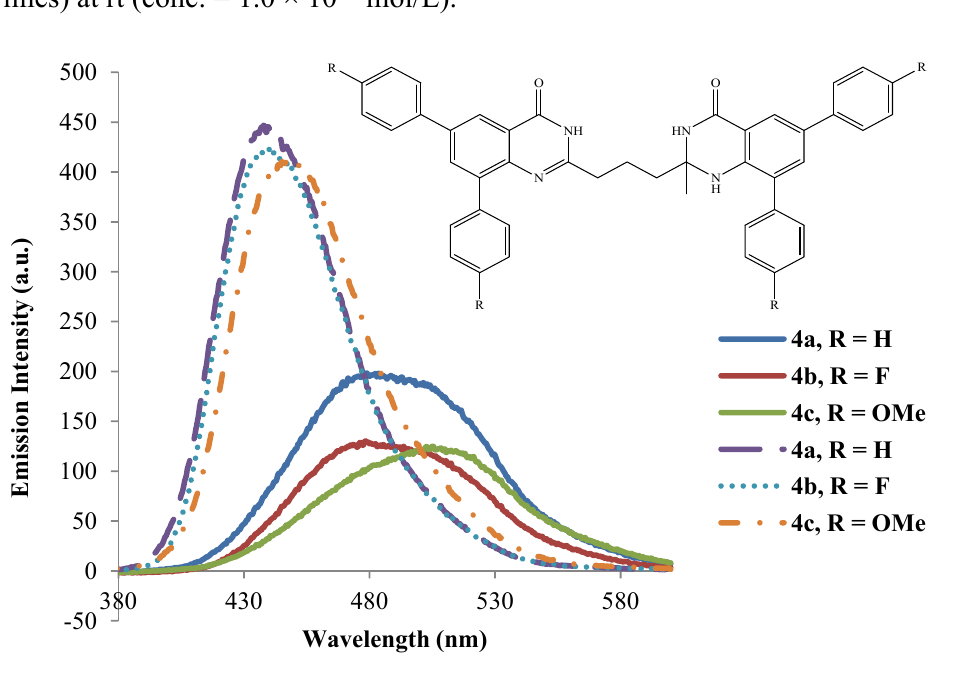
Figure 6. Emission spectra of 4a – c ( λ (solid lines) at rt (conc. = 1.0 × 10 − 4 mol/L).